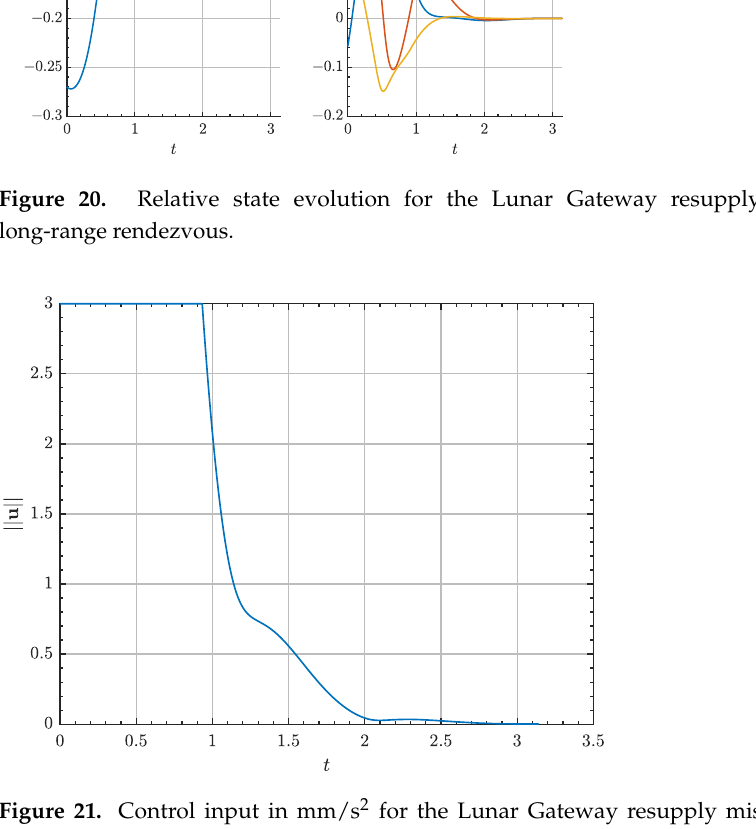
Figure 21. Control input in mm/s 2 for the Lunar Gateway resupply mission during the long- range